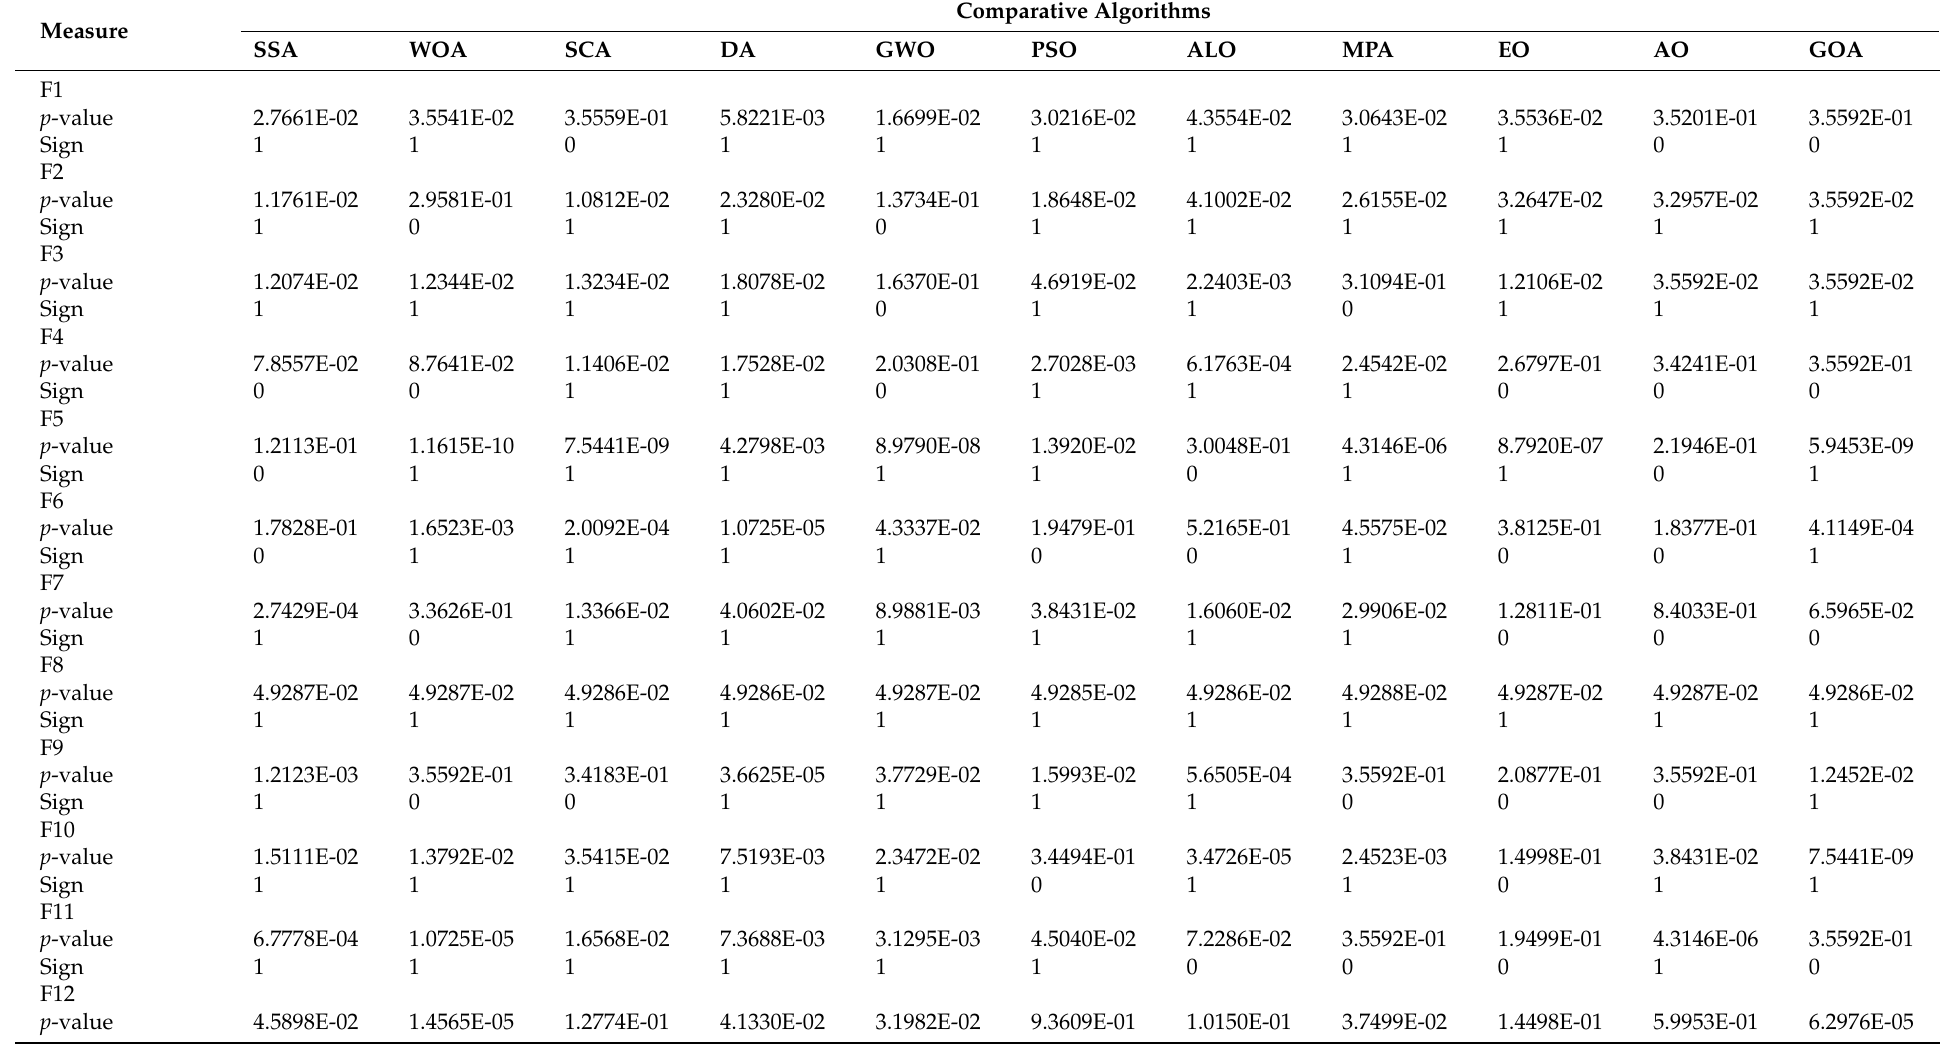
Table 6. The results of the Wilcoxon ranking test of the comparative methods using 23 classical benchmark